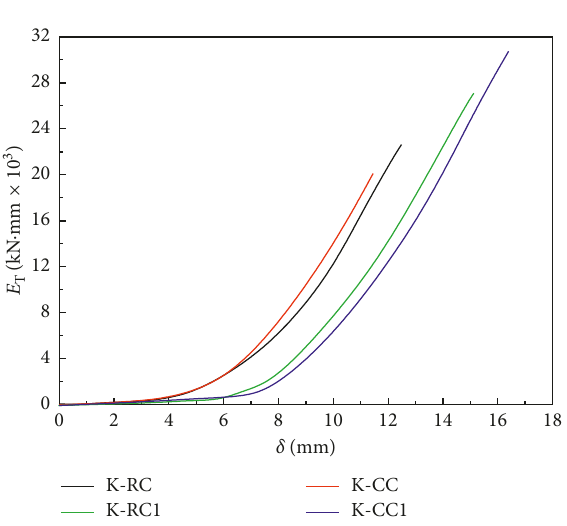
Figure 9: The relationship curve of E and displacement.